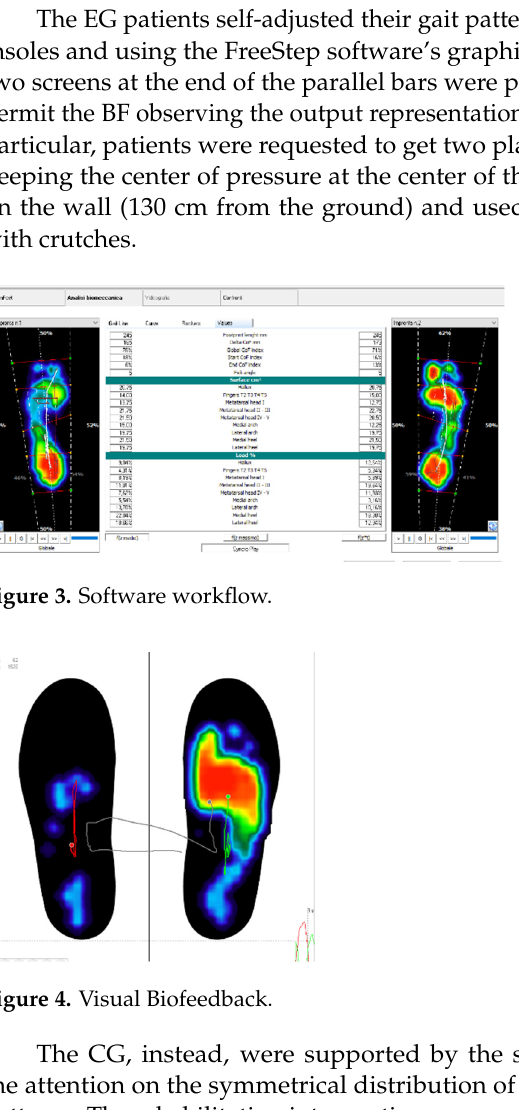
Figure 2. Experimental setting.